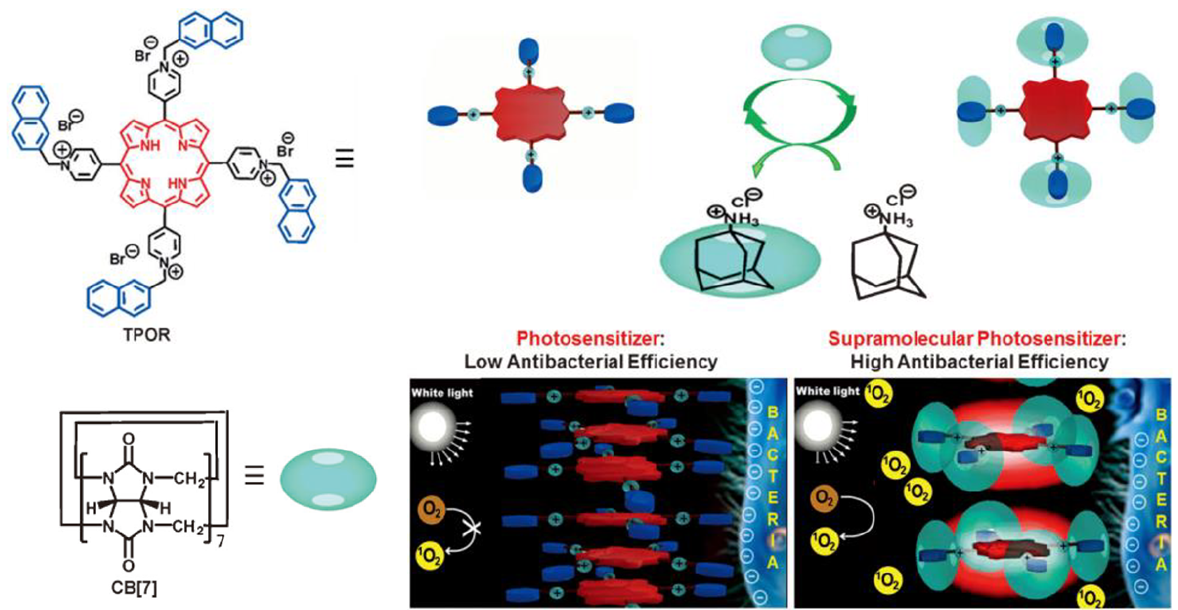
Figure 7. The construction of TPOR/(CB[7]) 4 supramolecular photosensitizers and the mechanism for the enhanced antibacterial efficiency of TPOR/(CB[7]) 4 compared with that of TPOR. Reprinted with permission from Ref. [88]. Copyright 2019 Wiley-VCH.